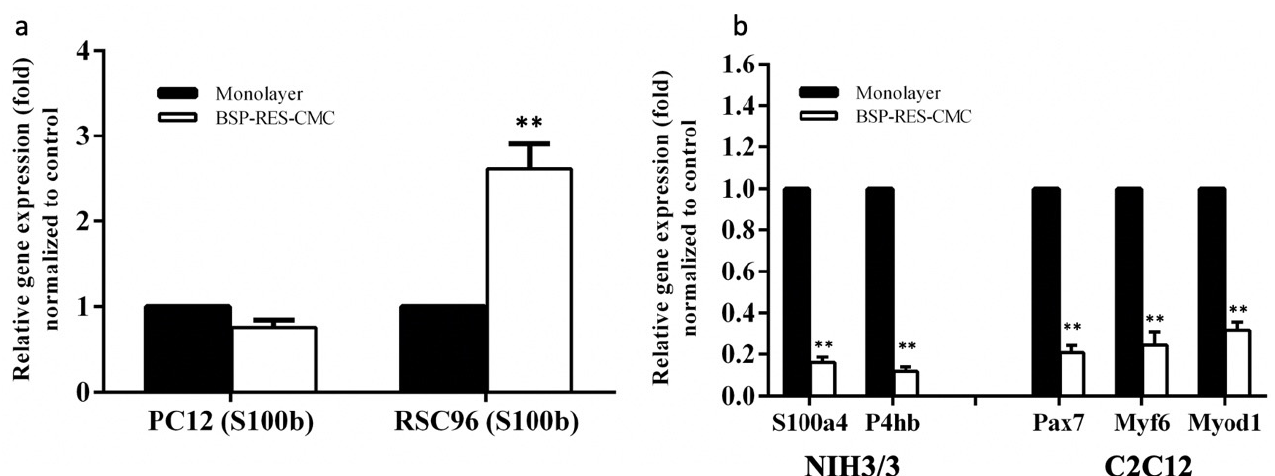
Figure 8. Gene expression in ( a ) PC12 and RSC96; ( b ) NIH/3T3 and C2C12 cell lines cultured in monolayers or CMC-BSP- RES sponges. **: p < 0.01, compared with monolayer.